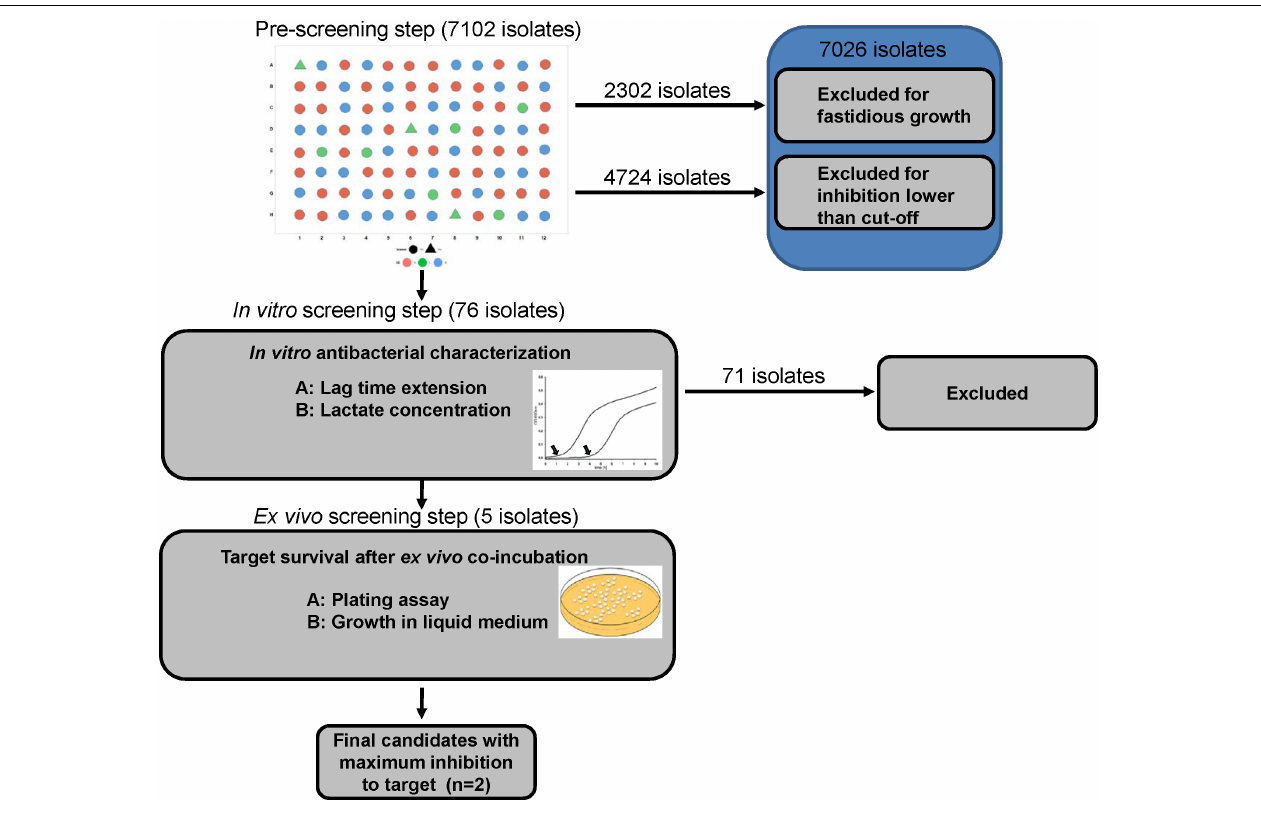
FIGURE 1 | Experimental design of the